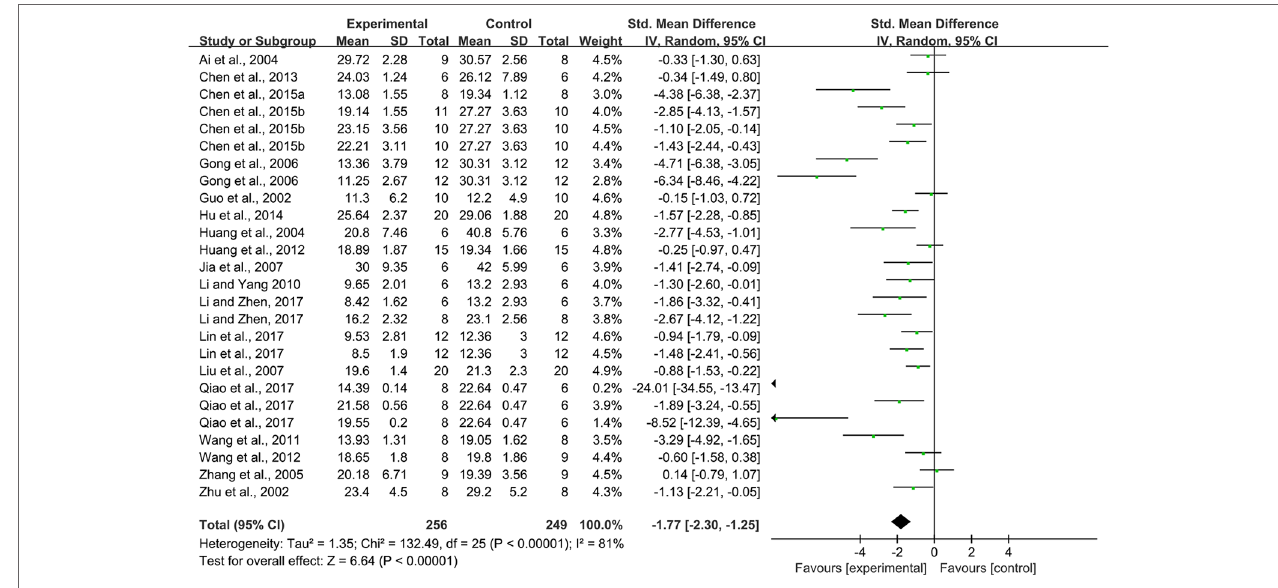
FiGURe 2 | Pooled estimate of blood glucose with rhein.